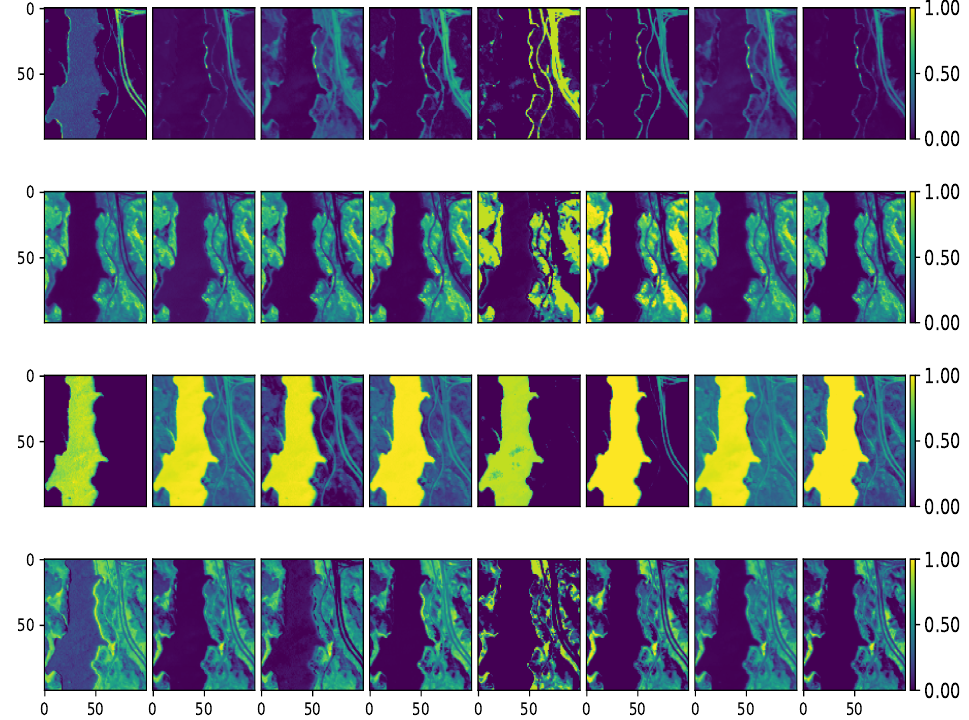
Figure 7. Estimated abundance maps of Jasper Ridge dataset. From left to right: VCA-K-Hype, N-FINDR-NDU, rNMF, DAEN, CYCUNET, Pixel-based DCAE, Modified Pixel-based DCAE, and the proposed method, respectively. From top to bottom: Road, Trees, Water, and Soil, respectively.